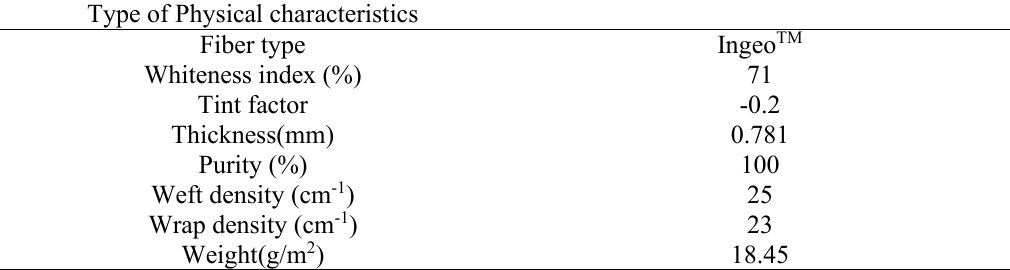
/H 3 2 3 /H 2 O process